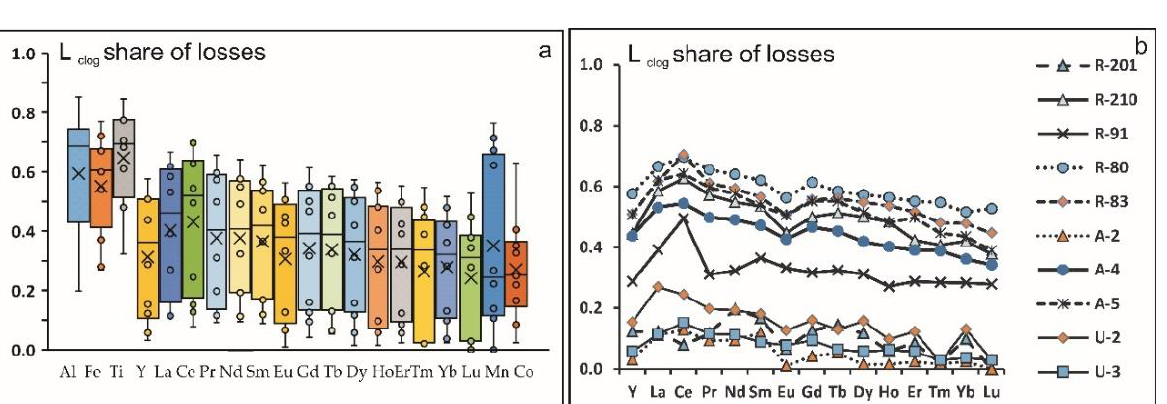
Figure 6. Share of losses (L clog ) of filterable forms of metals due to clogging during filtration of 0.5 L of Razdolnaya R. (□), Amur R. (◊), Ussuri R. (о) at the different contents of suspended solids (SS) for the elements: ( a ) Fe; ( b ) Al; ( c ) Mn; ( d ) Ce; ( e ) Dy; ( f ) Co. Despite the notable variability within the rivers, the range of metals by their share of losses due to clogging during filtration of 0.5 L of river water is obvious (Figure 7a). For the Y and REEs, the significant (by Mann–Kendall Z test) declining trend of the share of losses from La to Lu was observed in all rivers studied (Figure 7b) in accordance with a higher affinity of light REEs to the coarse colloids [39] more susceptible to the clogging.